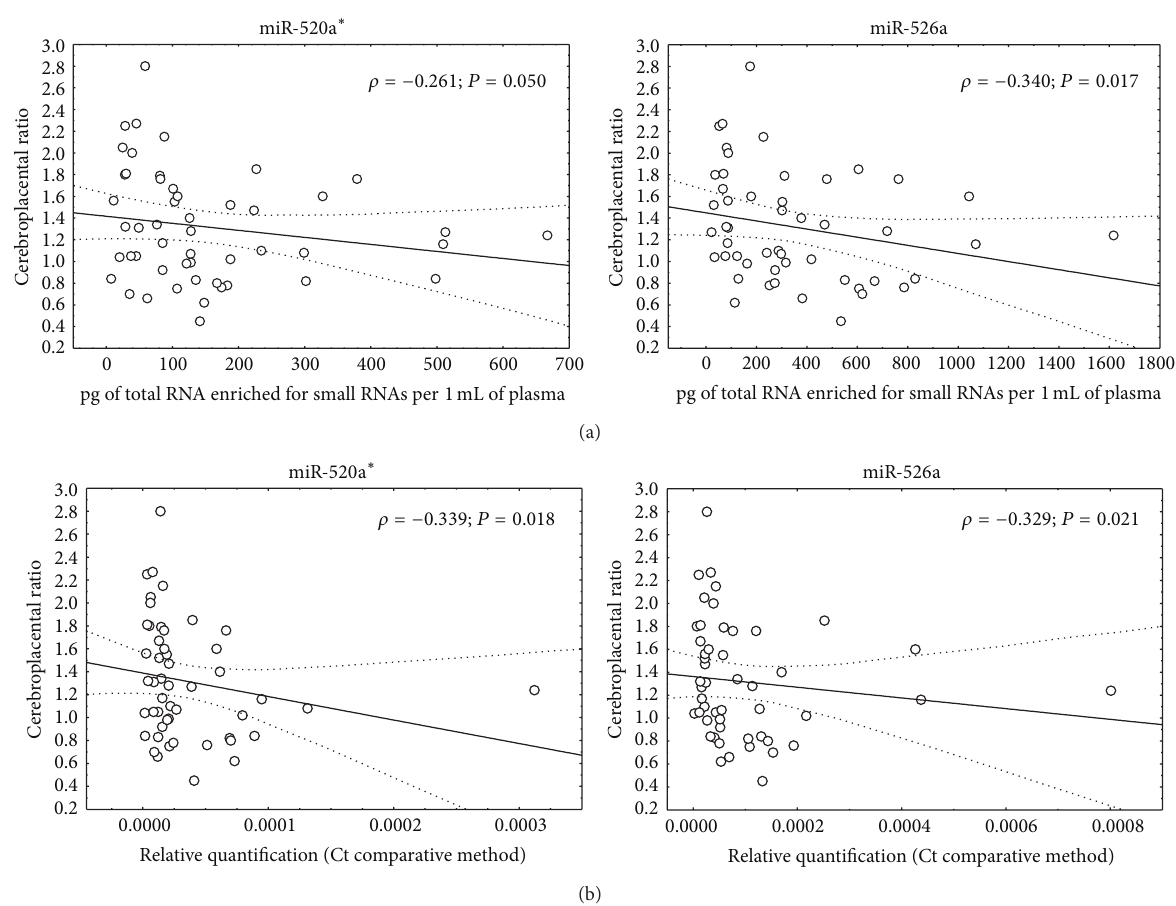
Figure 2: The association between the plasmatic concentration (a) and expression levels (b) of C19MC microRNAs and Doppler ultrasonography parameters. 𝜌 : Spearman’s correlation coefficient; P : level of significance.